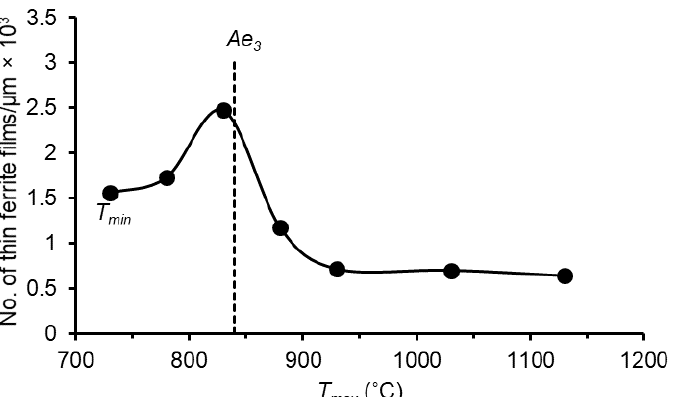
Figure 5. PAGBs thin ferrite film concentration as a function of rebound temperature ( T max ) from a T min of 730 °C. After an initial increase below Ae 3 , the number of films drops sharply above 830 °C due to re-austenitisation but stabilizes at approximately 930 °C.